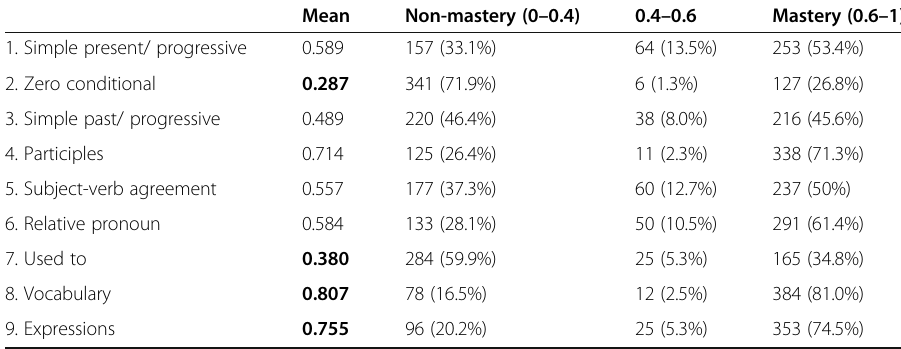
Table 6 Mean mastery probabilities and 474 examinee percentages of attributes